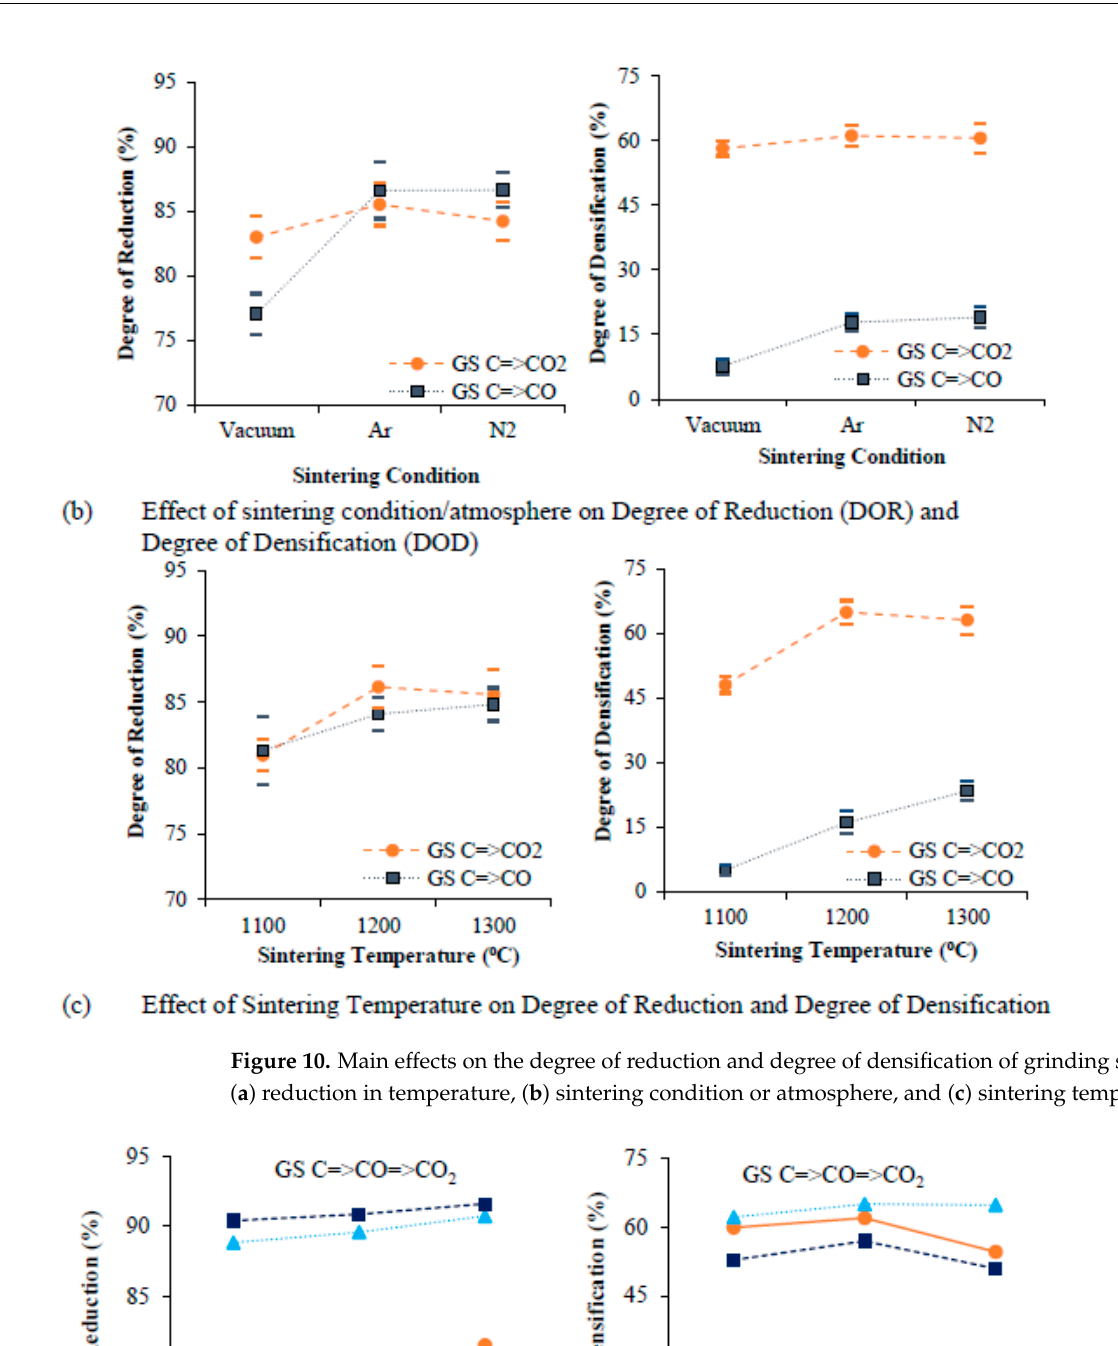
Figure 10. Main effects on the degree of reduction and degree of densification of grinding sludge: